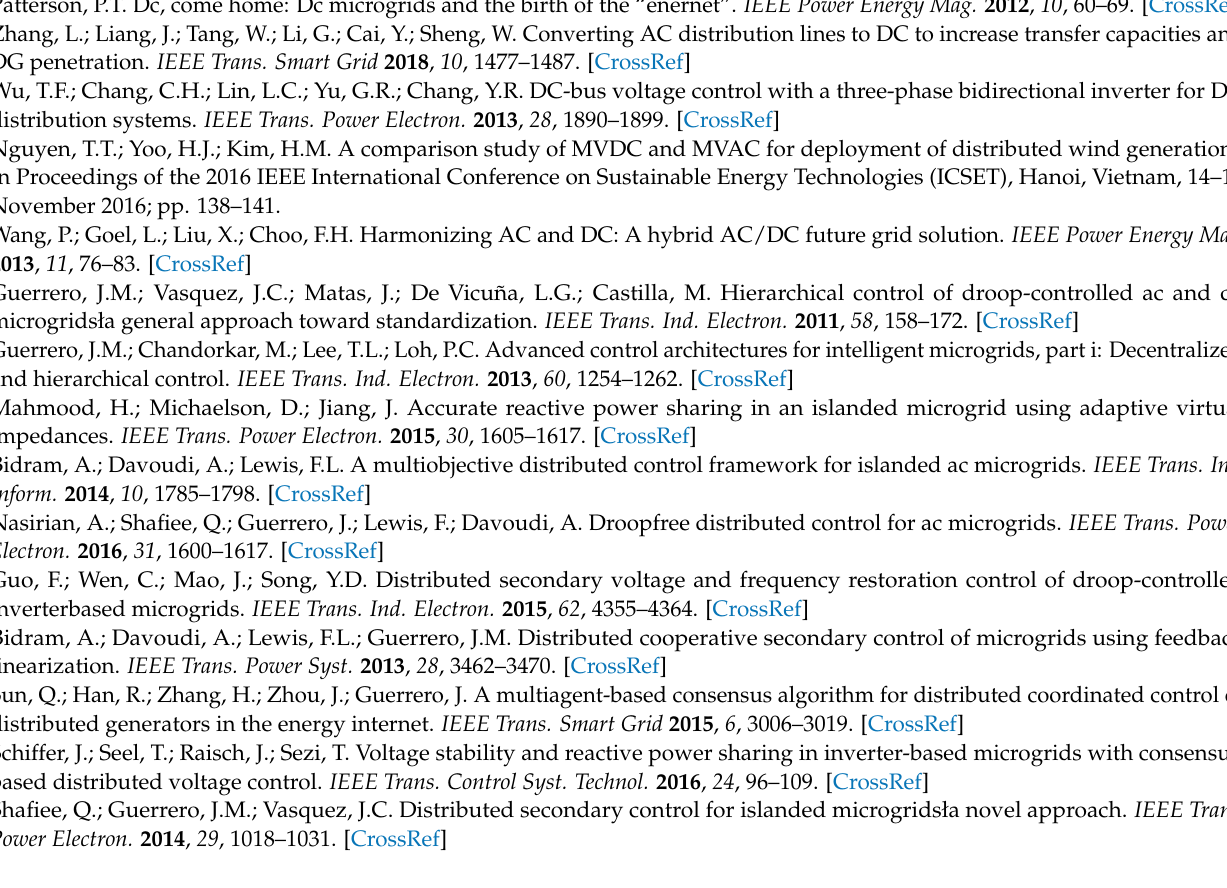
Figure A7. Concise block diagram of the supervisory power coordination.